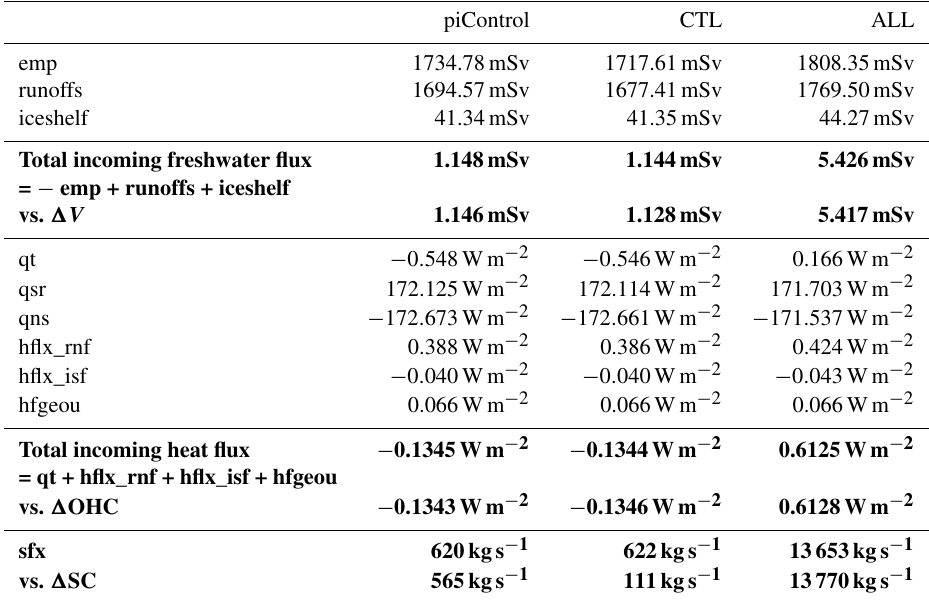
Table 2. Freshwater, heat and salt budgets over 1850–2100 in the piControl, CTL and ALL experiments (see Table 1 for the signification of each flux component). All fluxes are globally averaged. Global ocean changes (volume, heat and salt contents) are converted to flux units for comparison. The total freshwater, heat and salt budgets are indicated in